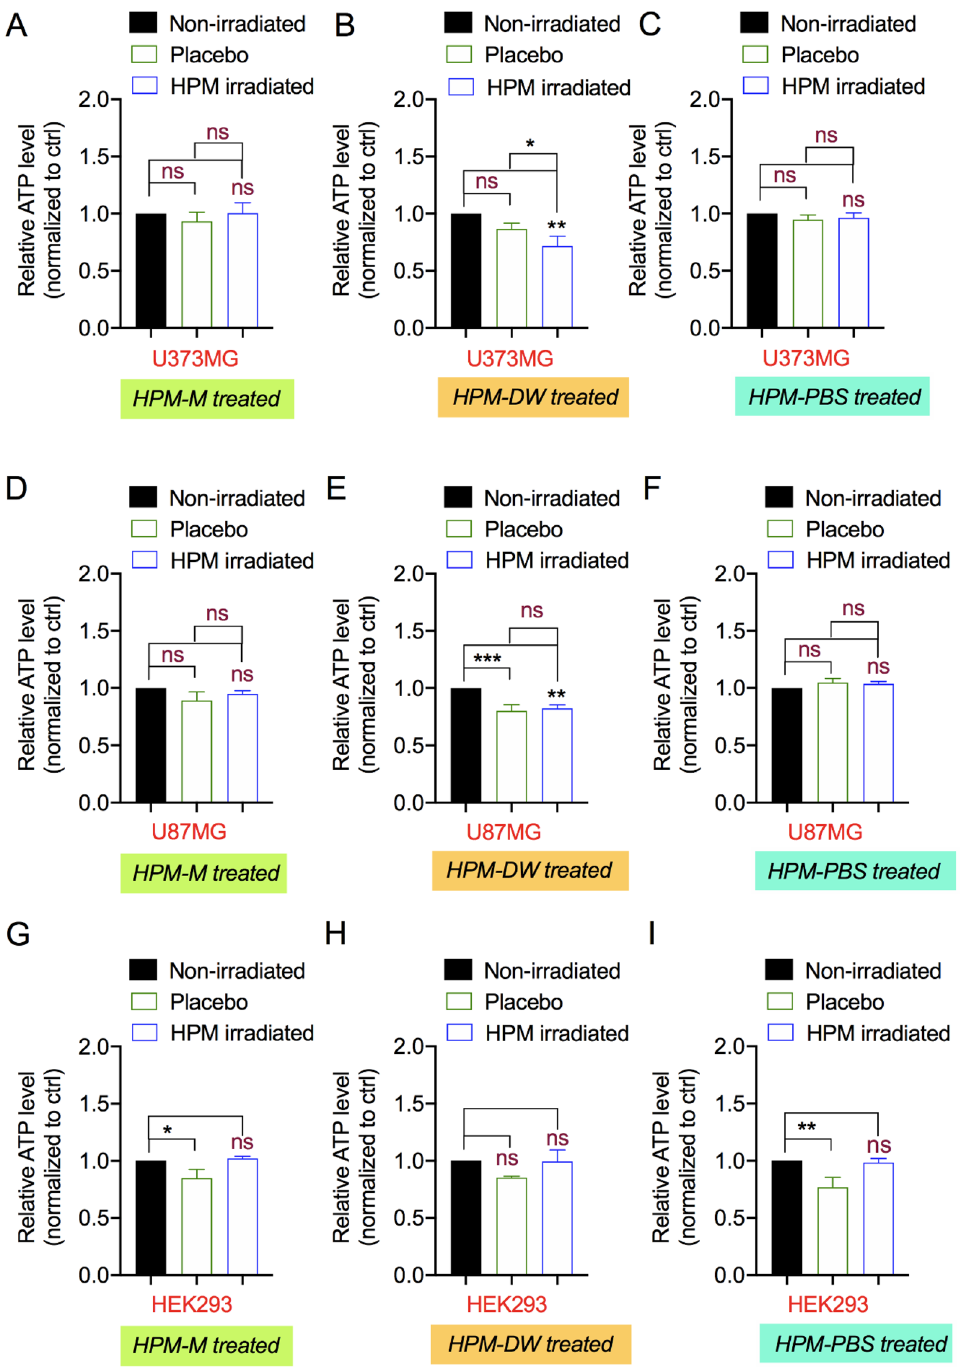
Figure 4. Effects of high power microwave-irradiated solutions on cellular energetics. The Cell-Titer Glo assay was used to measure ATP levels in U373MG cells treated with HPM-irradiated ( A ) Media, ( B ) DW, and ( C ) PBS; in U87MG cells reated with HPM-irradiated ( D ) Media, ( E ) DW, and ( F ) PBS; and in HEK293 cells treated with HPM-irradiated ( G ) Media, ( H ) DW, and ( I ) PBS. Non-significance is denoted as ns. * p < 0.05, ** p < 0.01, *** p <